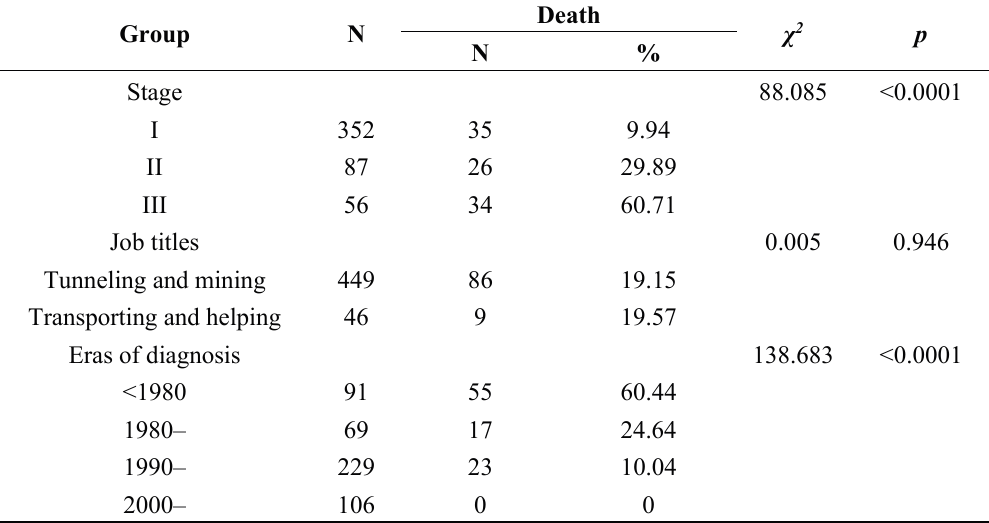
Table 6. The death status of CWP